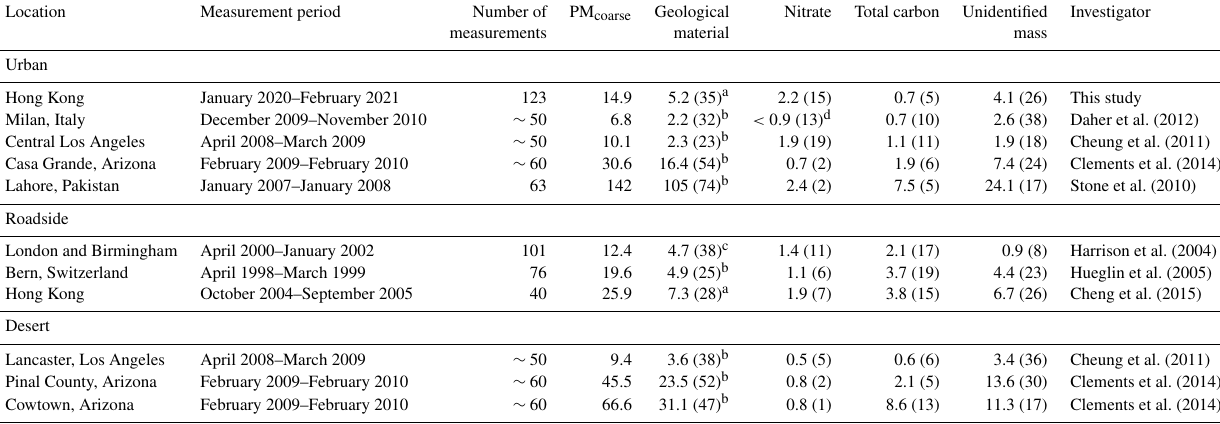
Table 1. Comparison of PM coarse concentration and major composition in micrograms per cubic metre (percentage contribution to PM coarse shown in parentheses) in Hong Kong and measurements in other